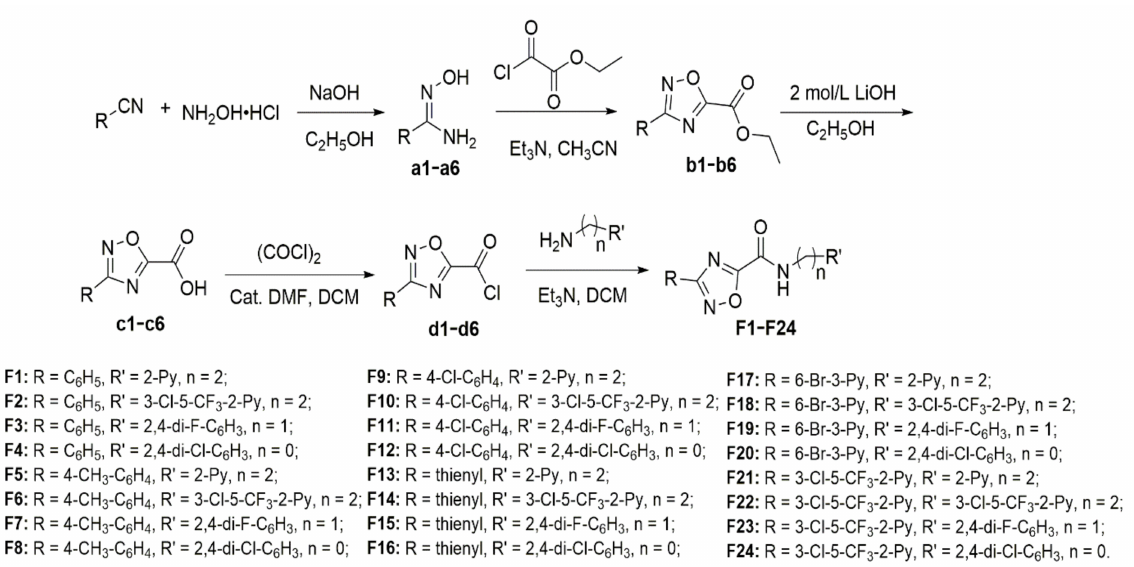
Scheme 1. Schematic representation of synthesis of target compounds F1 – F24